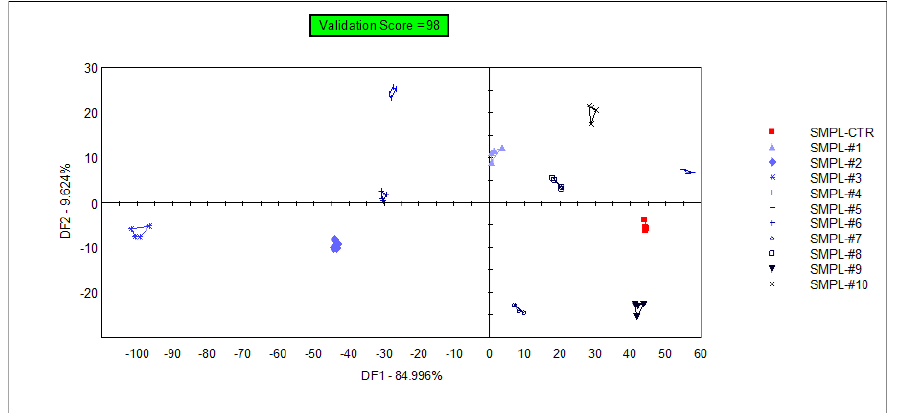
Figure 4. Graphical representation of the DFA classification of samples with different levels of S17-P100 supplementation obtained using data from all sensors (SMPL-CTR: milkshake with no supplementation (control); SMPL#1 to SMPL#10: milkshake samples with increasing levels of DHA supplementation (0.2–2%).